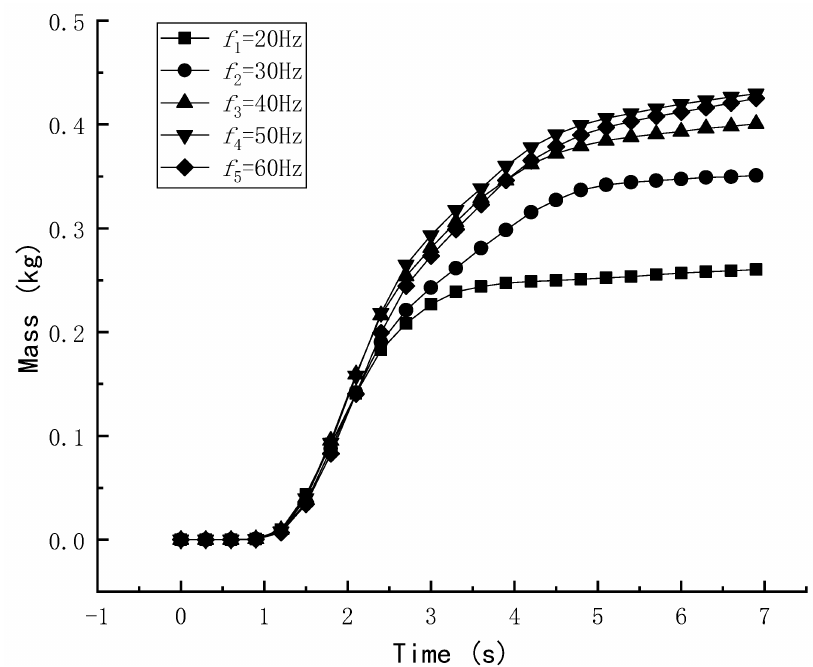
Figure 11. Curves of mass change of rice under different frequencies.